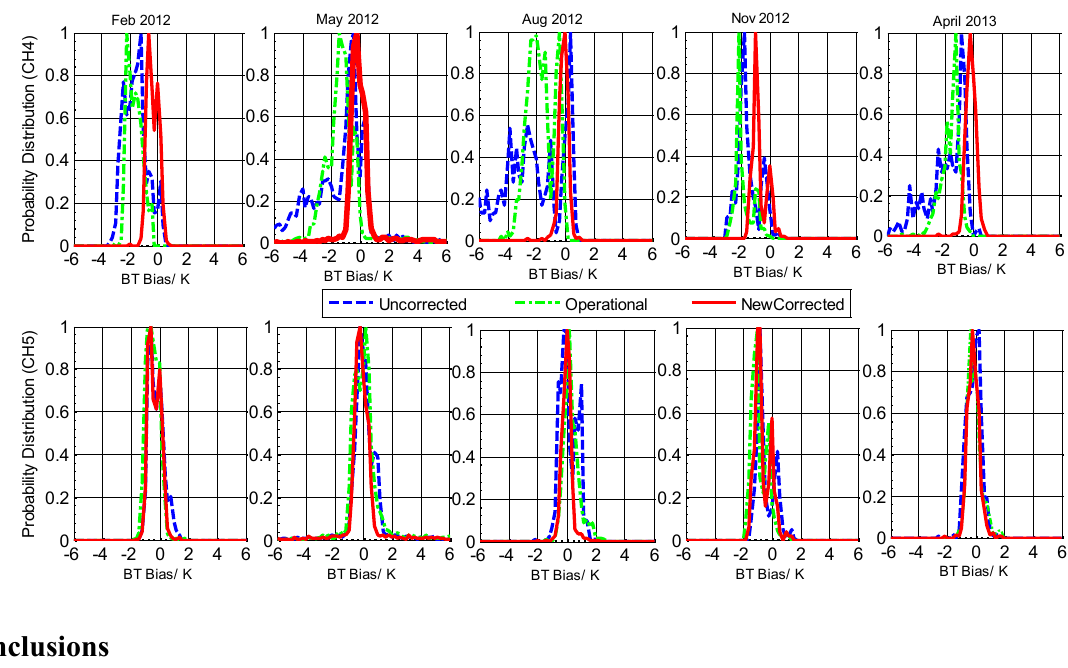
Figure 11. Normalized PDFs of FY-3A/VIRR BT biases in different months. The legends Uncorrected, Operational, and NewCorrected, respectively, indicate the calibrated BTs without nonlinear correction, with operational correction, and with new correction. The top figures are for channel 4, and the bottom figures are for channel